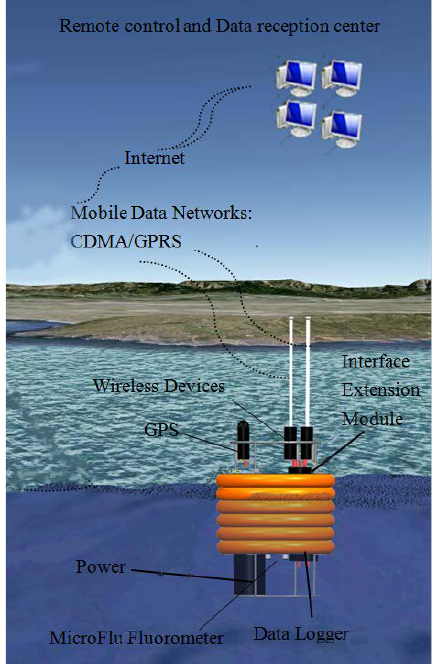
Figure 2. The schematic diagram of the in situ unattended sensor system and platform.